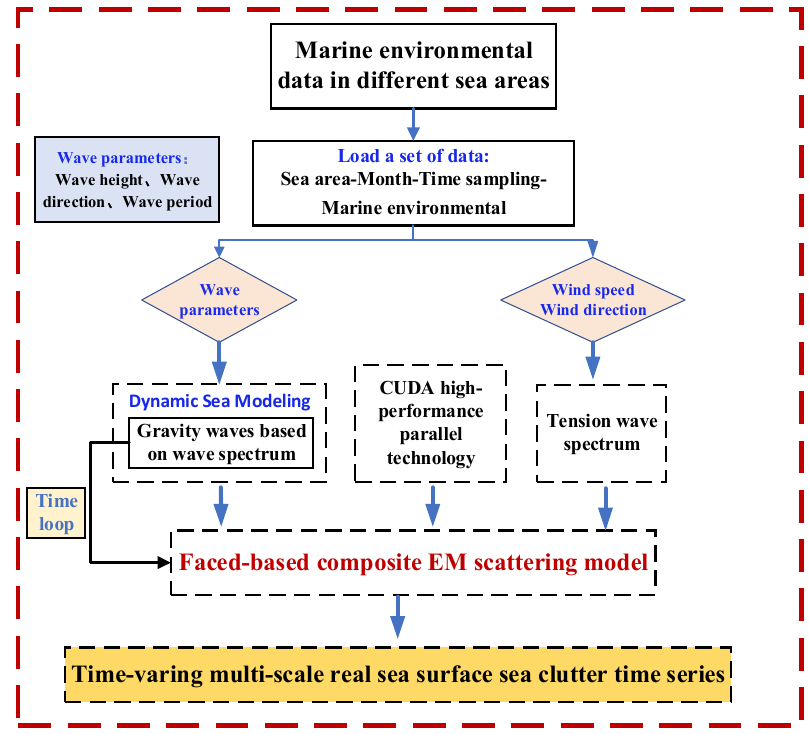
Figure 5. Schematic diagram of sea clutter time series modeling of sea surface with marine environ- mental elements in different sea areas.